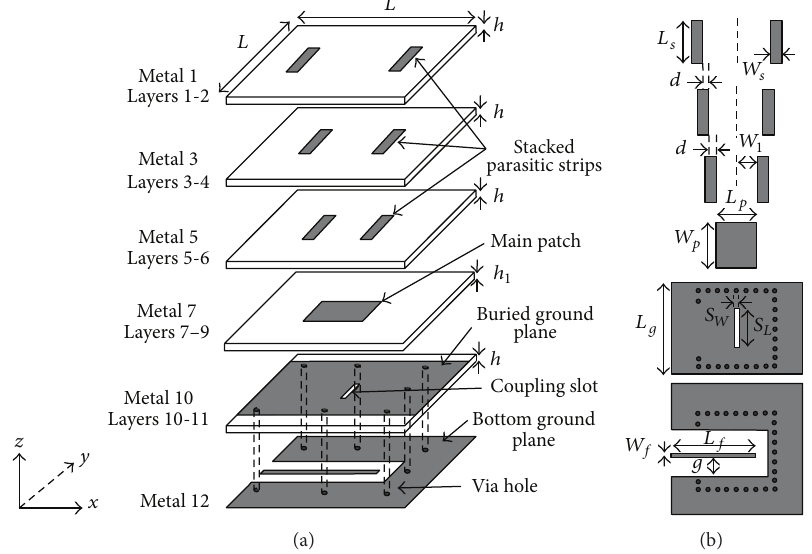
Figure 1: Configuration of the proposed antenna. (a) Expanded view. (b) Metal layer details.